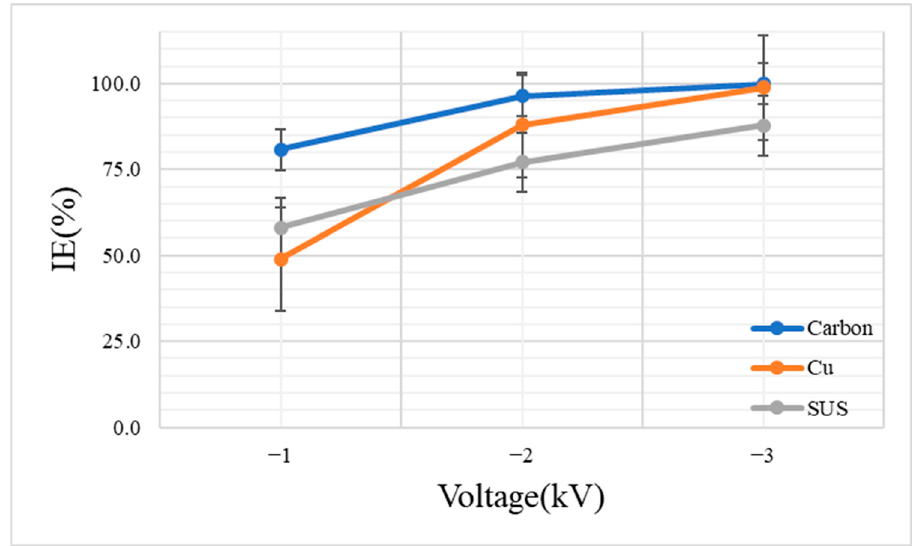
Figure 3. Inactivation efficiency (%) of the aerosolized MS2 bacteriophages in each material and at each voltage.